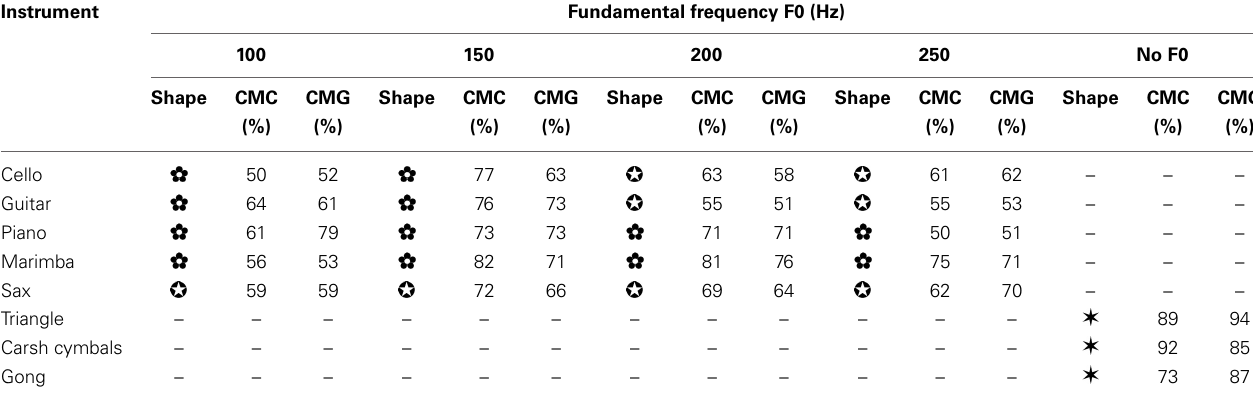
Table 1 | Shape selections for timbre: the colored and grayscale shapes selected for each sound are shown in this table.